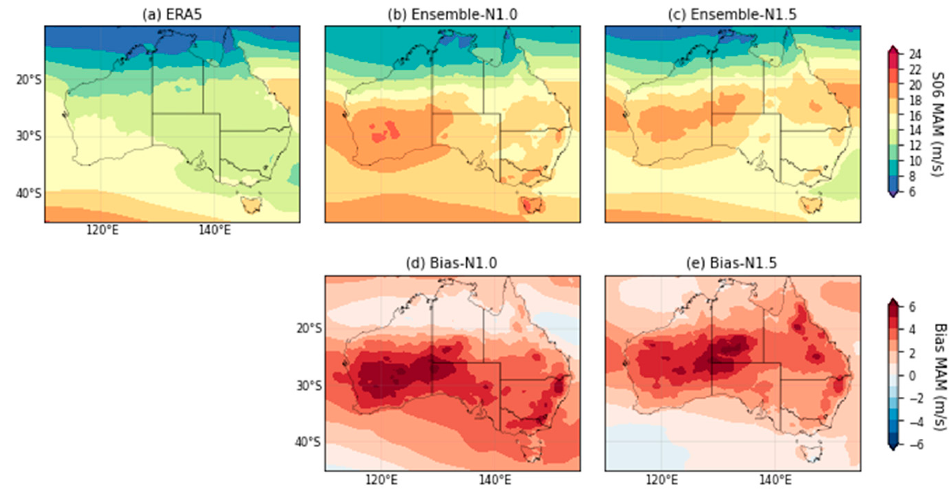
Figure A13. As in Figure A11 except for MAM.